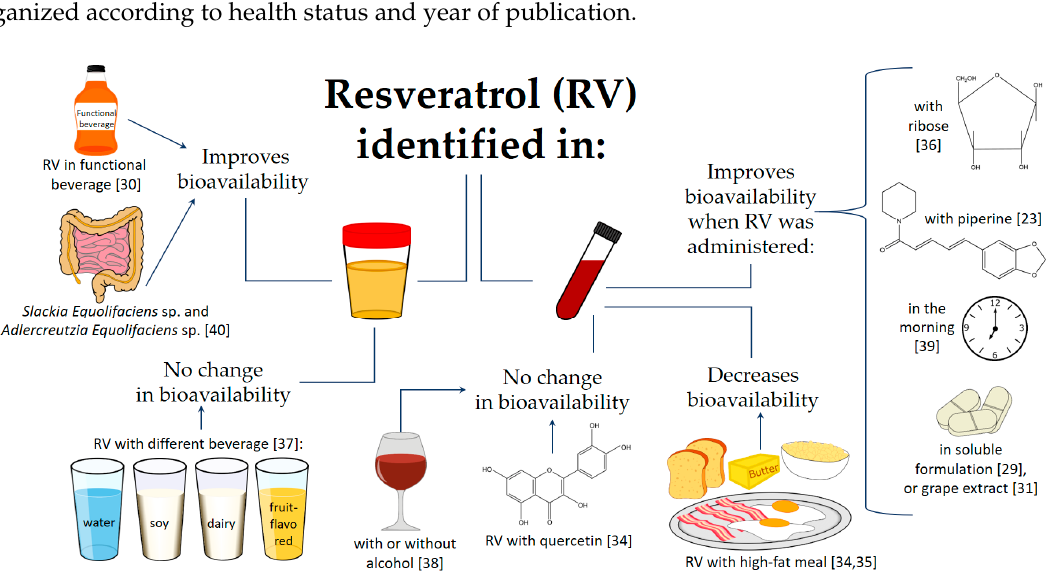
Figure 1. Bioavailability and pharmacokinetics. The image summarizes the results of different studies that identified resveratrol (RV) in urine and blood.